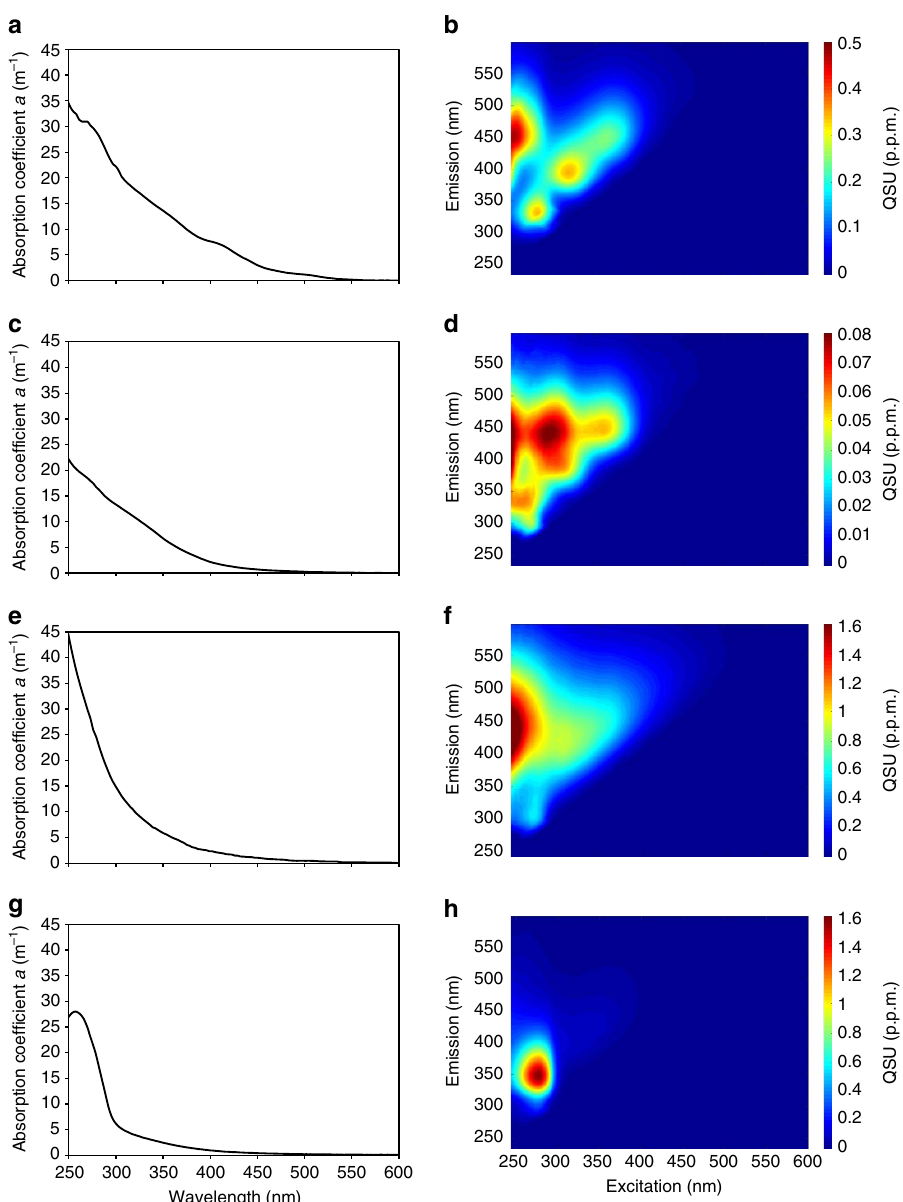
Figure 1 | Optical properties of picocyanobacteria, marine and heterotrophic bacteria DOM. Ultraviolet–Vis absorption and EEM fluorescence spectra of ( a , b ) Synechococcus -derived SPE-DOM, ( c , d ) Prochlorococcus -derived SPE-DOM, ( e , f ) SPE-DOM collected from the Sargasso Sea (BATS at 4,530m depth) in August 2013 and ( g , h ) heterotrophic bacterium R. pomeroyi -derived SPE-DOM. Note: cell density was different in each culture and preclude a direct comparison of fluorescence intensity, and hence the given ultraviolet–Vis and EEM data are only intended to compare peak shapes and not intensities.